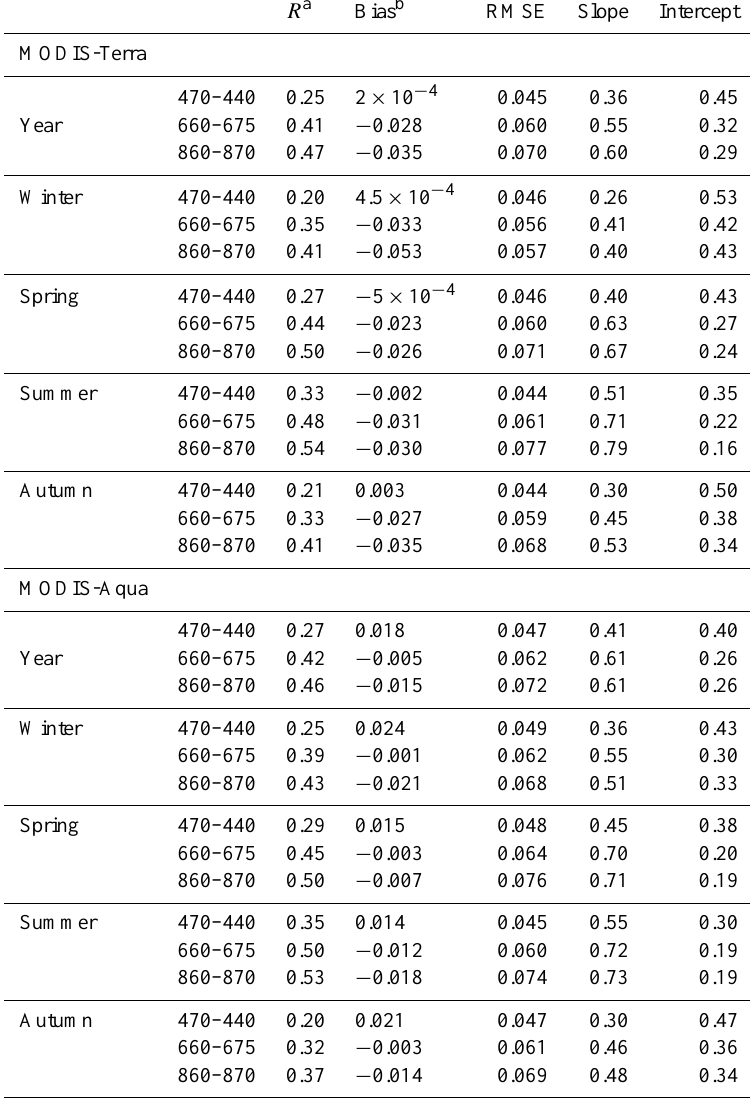
Table 1. Correlation coefficients ( R ), mean bias, root mean squared error (RMSE) and the slope and intercept values of applied linear regression fits between MODIS and AERONET g aer data. The statistical parameters are given separately for the pairs of wavelengths: (i) 470nm (MODIS) and 440nm (AERONET), (ii) 660nm (MODIS) and 675nm (AERONET) and (iii) 860nm (MODIS) and 870nm (AERONET). The statistical parameters are also given separately for winter, spring, summer and